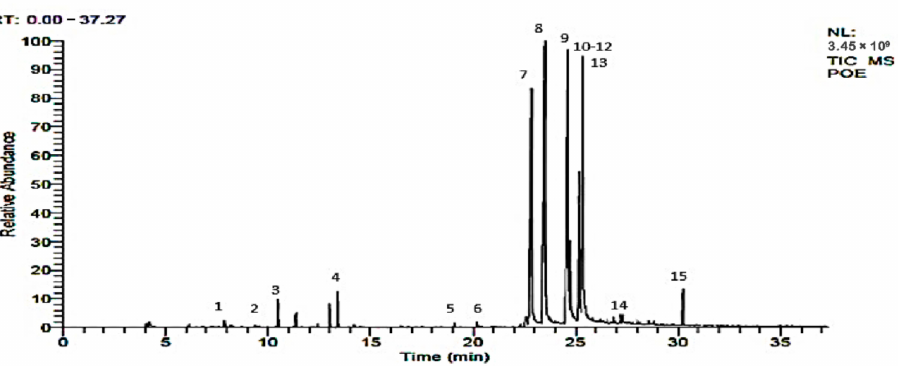
Figure 1. GC-MS chromatogram of Woodfordia fruticosa flower extract showing vital bioactive